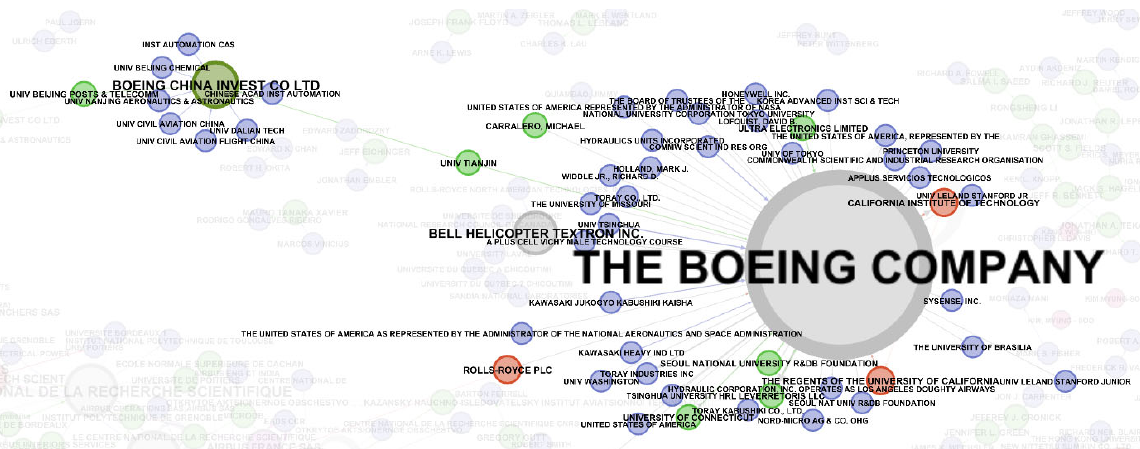
Figure 8. Network Analysis for BOEING.